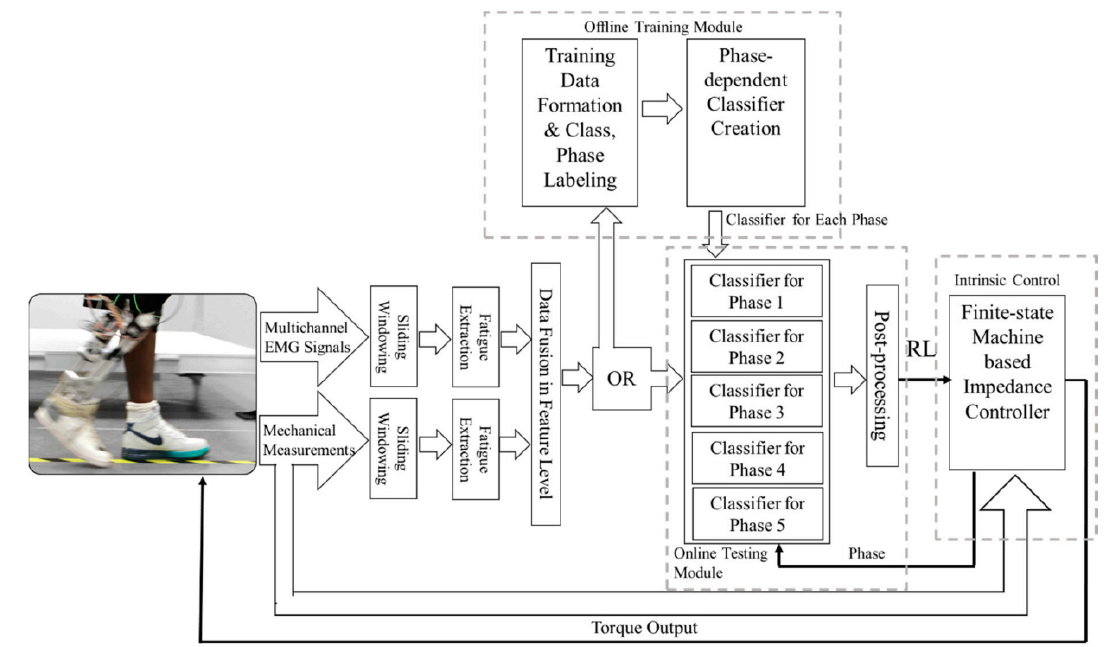
Figure 10. EMG-GRF fusion strategy and the fusion pipeline to recognize different locomotion modes adapted from [27] .